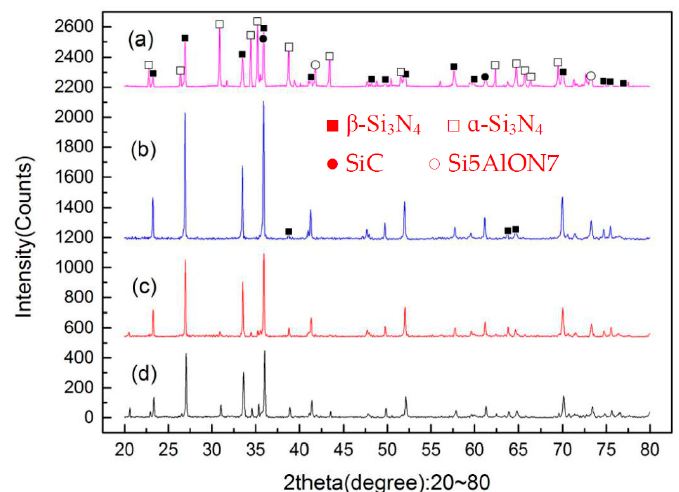
Figure 11. XRD results of the sintered Si 3 N 4 /n-SiC ceramics at different holding time (sintering temperature for 1600 °C), ( a ) 0 min, ( b ) 10 min, ( c ) 20 min, and ( d ) 30 min.